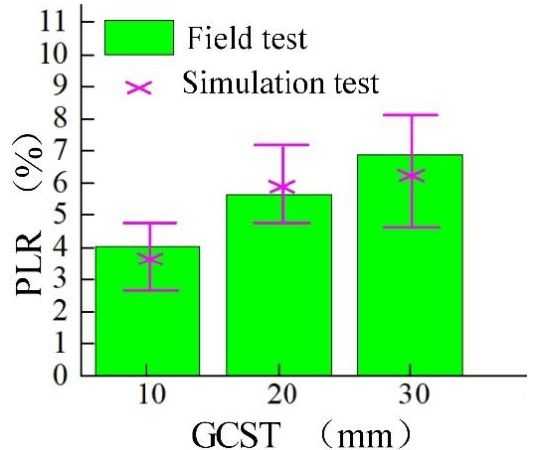
Figure 6. Comparison of test results. Table 3. Validation test comparison.